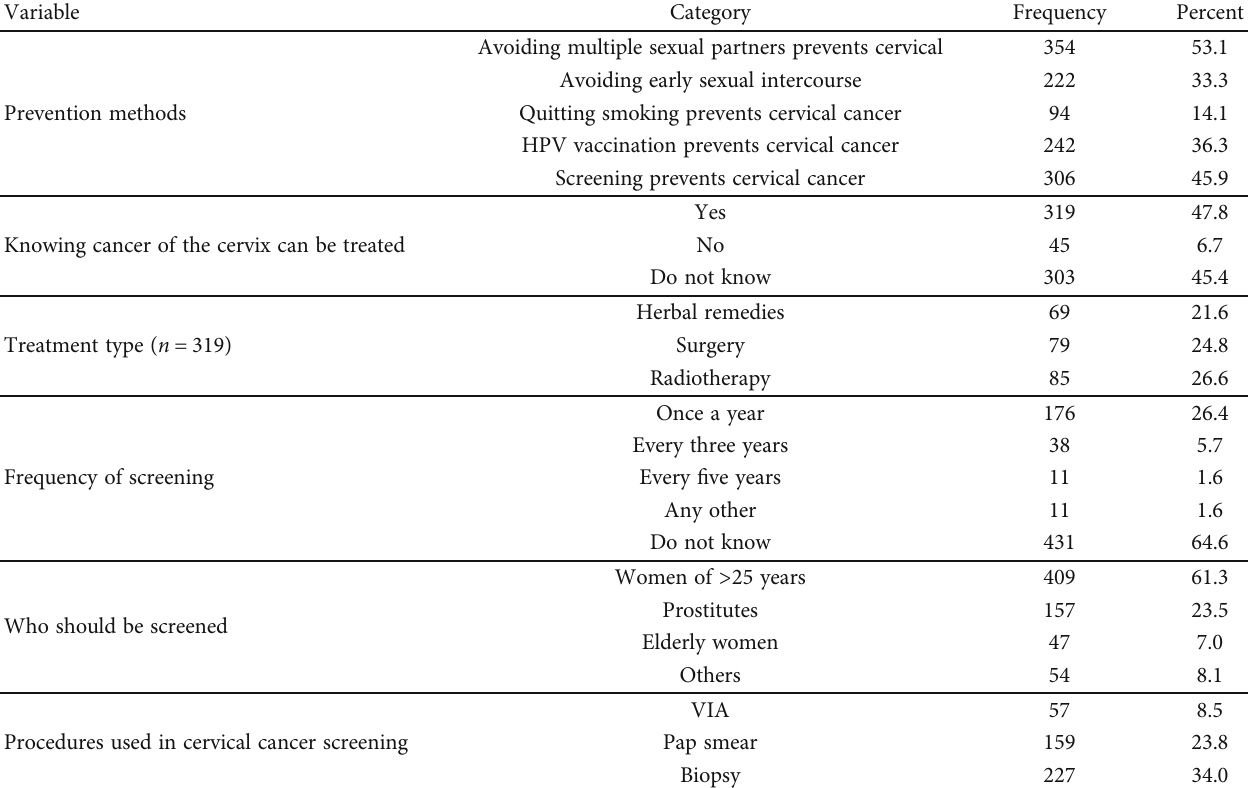
Table 4: Respondents ’ knowledge about prevention, treatment, and screening modalities of cervical cancer at Screening at Adama Science and Technology University, Adama, Ethiopia May 2014.